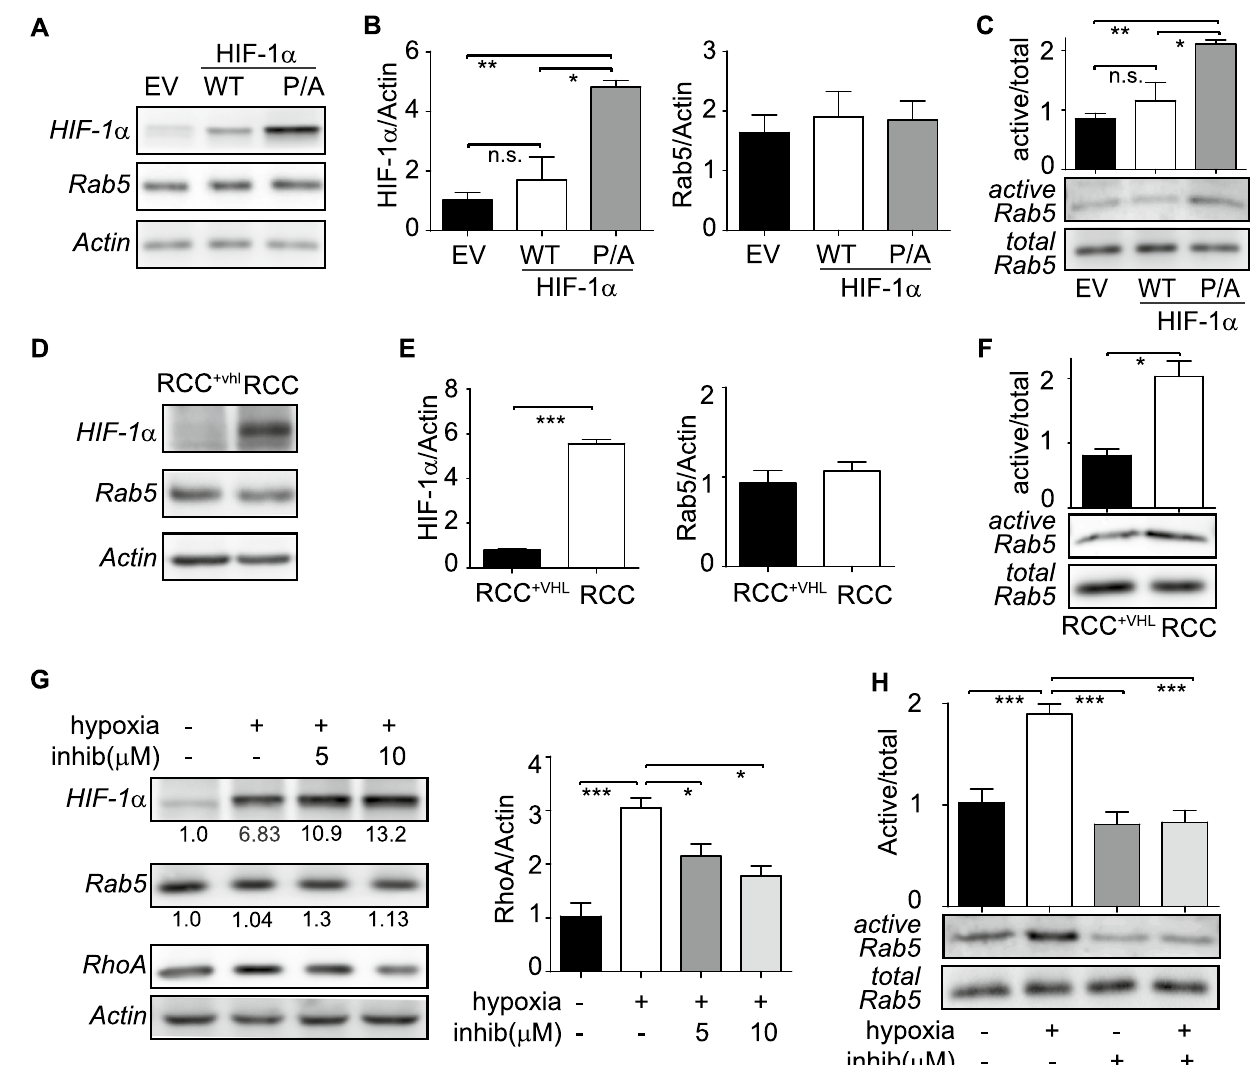
Figure 1. HIF-1α activates Rab5 in normoxia and hypoxia. ( A – C ) A549 cells were transfected for 24 h with pcDNA3.1 (EV), pcDNA3.1-HIF-1α WT (WT) or pcDNA3.1-HIF-1α P402A/P564A (P/A) and samples were used for subsequent analysis of total protein expression ( A , B ) and Rab5 activity analysis ( C ). ( A ) Representative Western blot images of HIF-1α, Rab5 and actin. ( B ) HIF-1α and Rab5 relative levels were quantified by scanning densitometry analysis and normalized to actin levels. Graphs represent the average from 3 independent experiments (mean ± SEM). * p < 0.05; ** p < 0.01; n.s., non-significant. ( C ) Rab5-GTP levels were measured in pulldown assays, as previously described by us (details in materials and methods). Lower panel, representative Western blot images of GTP-bound active Rab5 and total Rab5, respectively. Upper graph shows the average from 3 independent experiments (mean ± SEM), obtained by scanning densitometry analysis of active Rab5 and normalized with respect to total Rab5. * p < 0.05; ** p < 0.01; n.s., non-significant. ( D - F ) RCC4 and RCC4 +vhl cells were grown for 24 h and whole cell lysates were prepared for subsequent analysis of total proteins ( D , E ) and Rab5 activity ( F ). ( D ) Representative Western blot images of HIF-1α, Rab5 and actin. ( E ) HIF-1α and Rab5 relative levels were quantified as described in ( B ). Graphs represent the average from 3 independent experiments (mean ± SEM). *** p < 0.001. ( F ) Rab5-GTP levels were measured in pulldown assays, as mentioned in ( C ). Lower panel, representative Western blot images of active and total Rab5. Upper graph shows the average from 3 independent experiments (mean ± SEM; * p < 0.05). ( G ) A549 cells were incubated in normoxia or hypoxia (1% O 2 ) for 24 h, in the presence of either DMSO (vehicle control) or HIF-1α inhibitor (C 26 H 29 NO 5 ), at the indicated concentrations, and whole cell lysates were prepared. HIF-1α, Rab5, RhoA and actin levels were assessed by Western blotting and quantified by scanning densitometry analysis. Numerical data below each panel represent relative HIF-1α and Rab5 levels (normalized to actin), respectively, and shown as follows. HIF-1α: normoxia/DMSO (1.00 ± 0.73), hypoxia/DMSO (6.83 ± 2.62), hypoxia/5 μM inhibitor (10.99 ± 2.66), hypoxia/10 μM inhibitor (13.26 ± 4.91). Rab5: normoxia/DMSO (1.00 ± 0.24), hypoxia/DMSO (1.04 ± 0.34), hypoxia/5 μM inhibitor (1.30 ± 0.55), hypoxia/10 μM inhibitor (1.13 ± 0.47). Numerical data are shown as the average of 3 independent experiments (mean ± SEM). The graph indicates relative RhoA levels (normalized to actin), and data are shown as the average of 3 independent experiments (mean ± SEM). * p < 0.05; *** p < 0.001. ( H ) A549 cells were incubated in normoxia or hypoxia (1% O 2 ), in the presence of DMSO or HIF-1α inhibitor, as described in ( G ), and Rab5-GTP levels were determined using the R5BD pulldown assay. Lower panels, representative Western blot images obtained from 3 independent experiments. Upper graph, relative Rab5-GTP levels normalized to total Rab5 by scanning densitometry are shown as the fold increase with respect to normoxia/ DMSO. Data represent the average of 3 independent experiments (mean ± SEM). ***p <